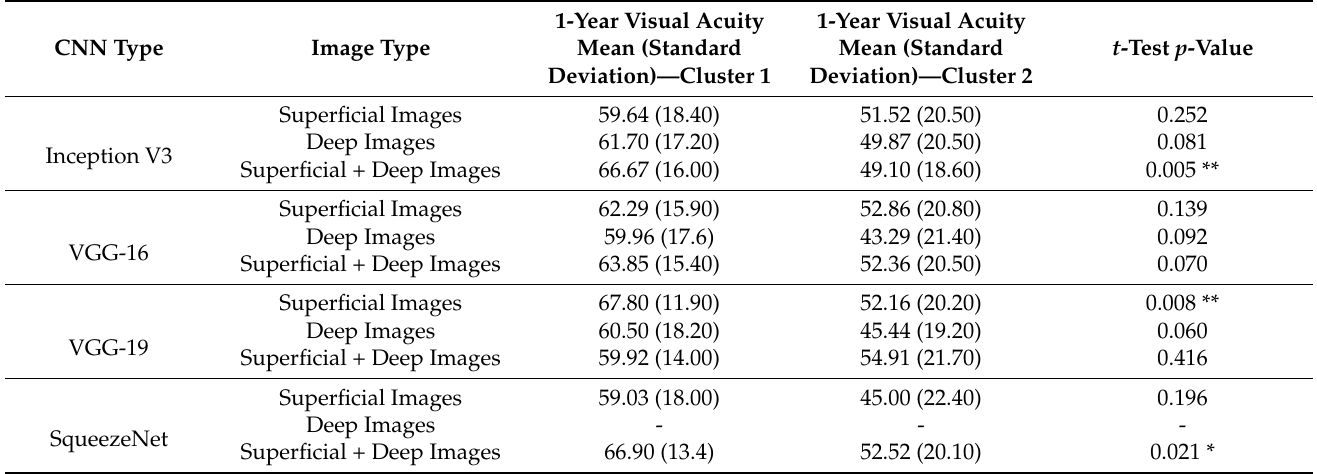
Table 2. Distribution of 1-year visual acuity score in the two image clusters for the different CNN types. * p < 0.05; ** p <